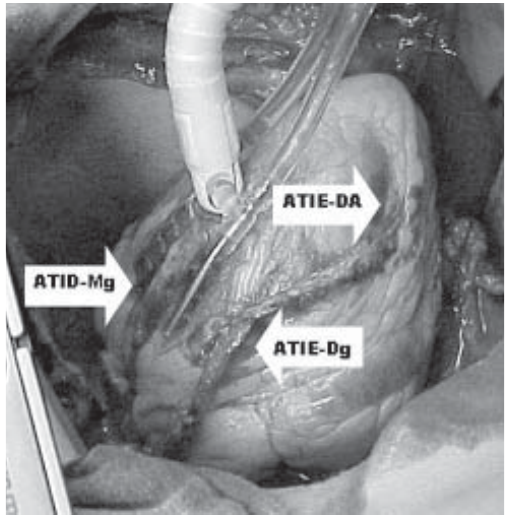
Fig. 2- Anastomose da artéria torácica interna direita (ATID) com a artéria marginal (Mg). Também são detalhadas as anastomoses seqüenciais da artéria torácica interna esquerda (ATIE) com a artéria coronária descendente anterior (DA) e ramo diagonal (Dg)